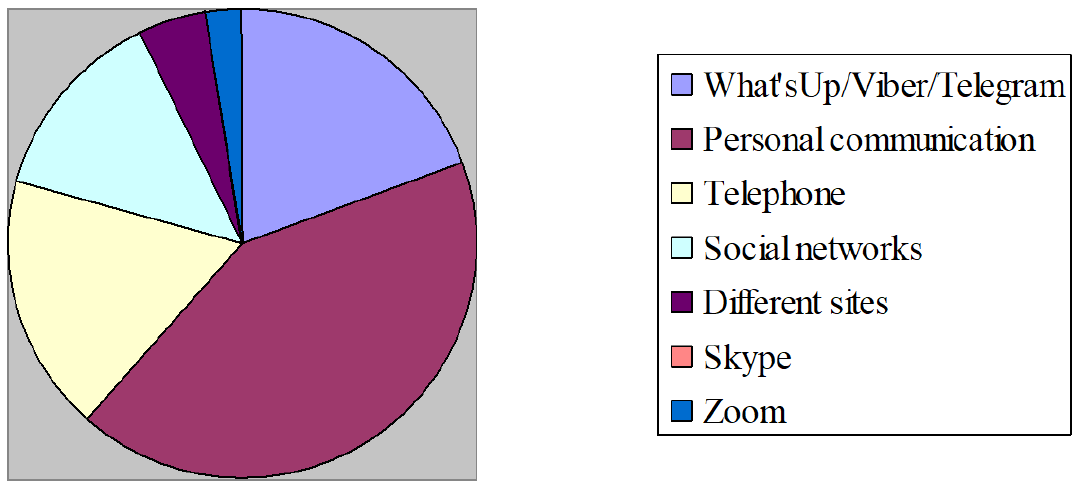
Figure 3 - The use frequency of different methods of communication in school No.